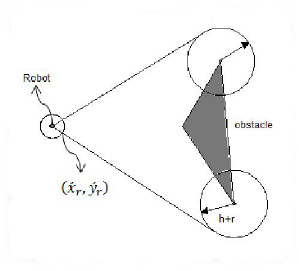
Fig. 2. Finding the end-point of obstacle Fig. 3. Finding the feasible path by considering the safe distance (h) and robot’s shape